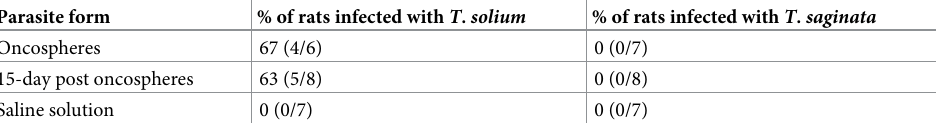
Table 2. Percent of rats infected after intracranial inoculation with T . solium and T . saginata oncosphere and PO form. Parasite form % of rats infected with T .